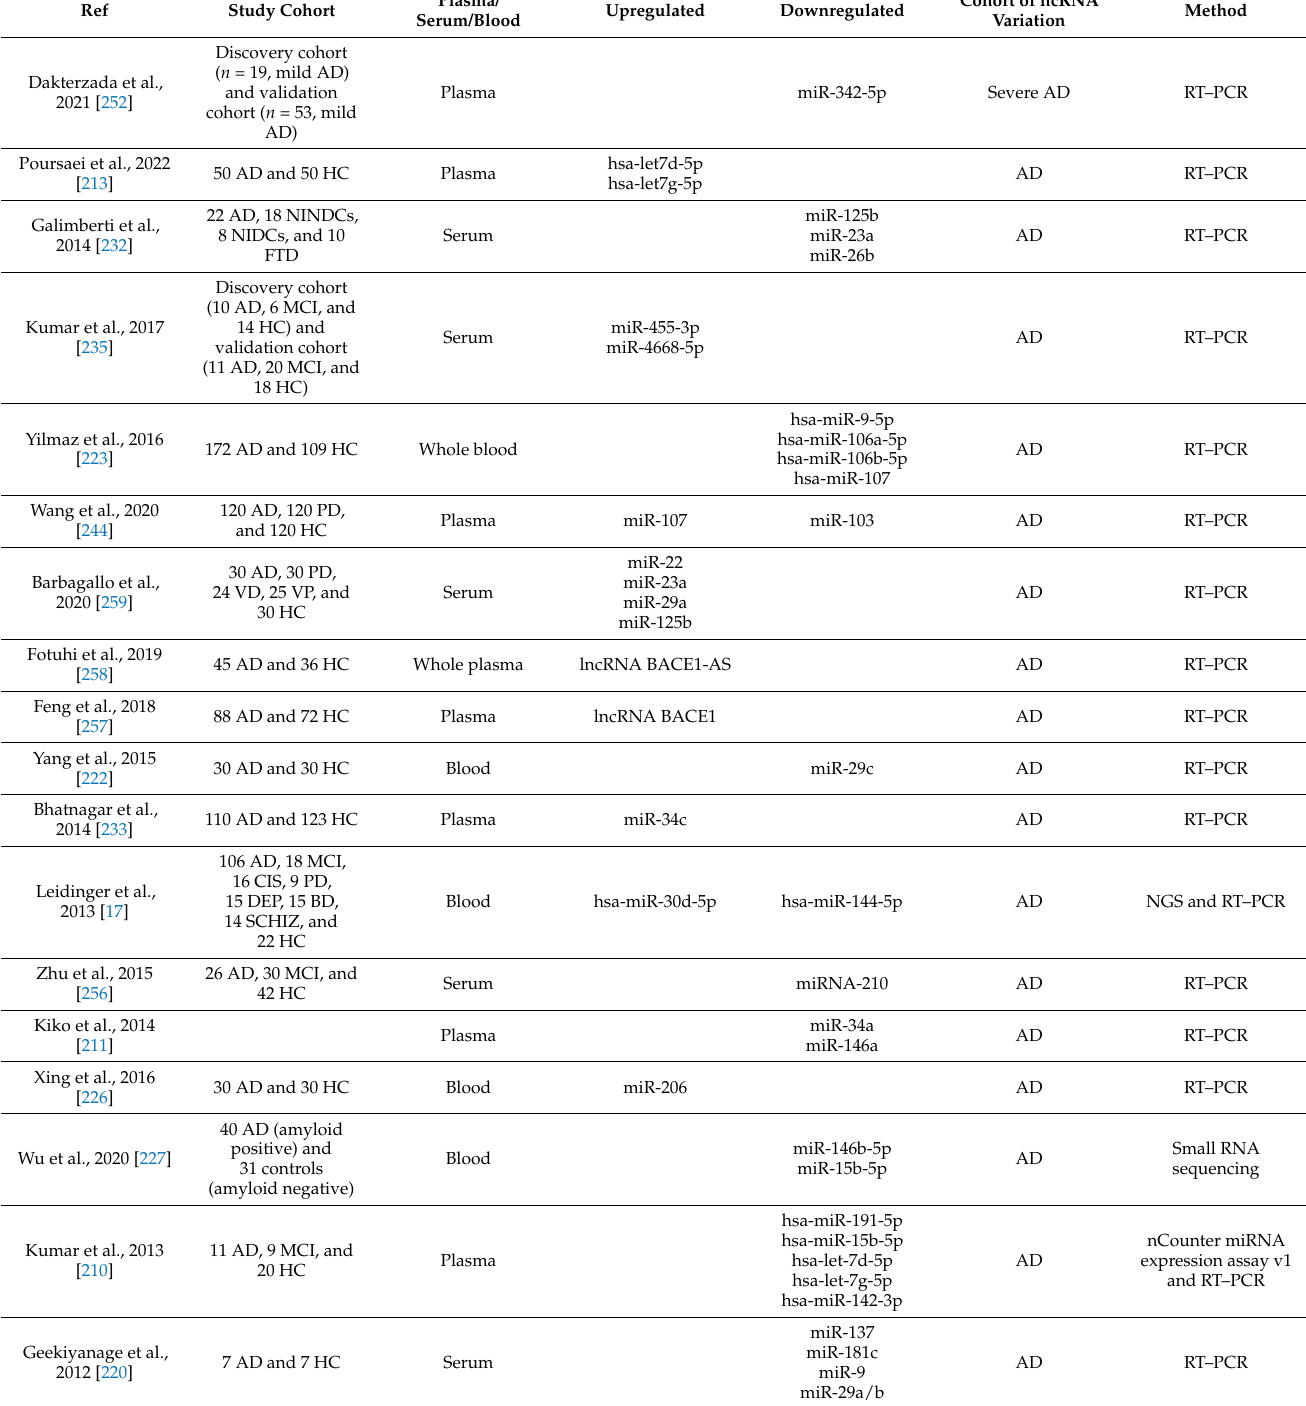
Table 2. Circulating ncRNAs as AD